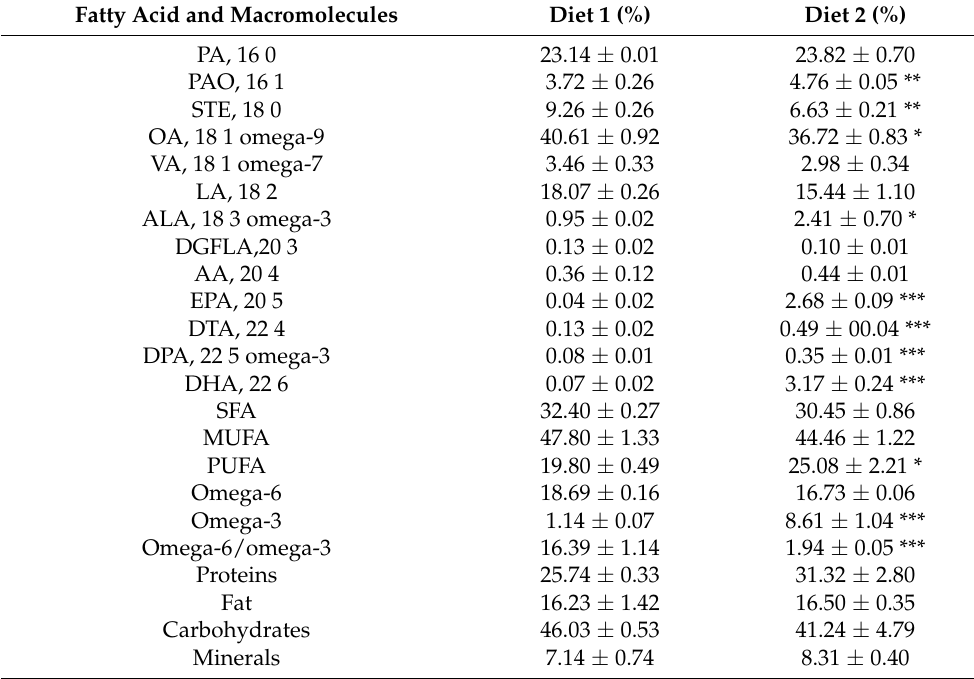
Table 1. The analytical composition of diets. Fatty Acid and